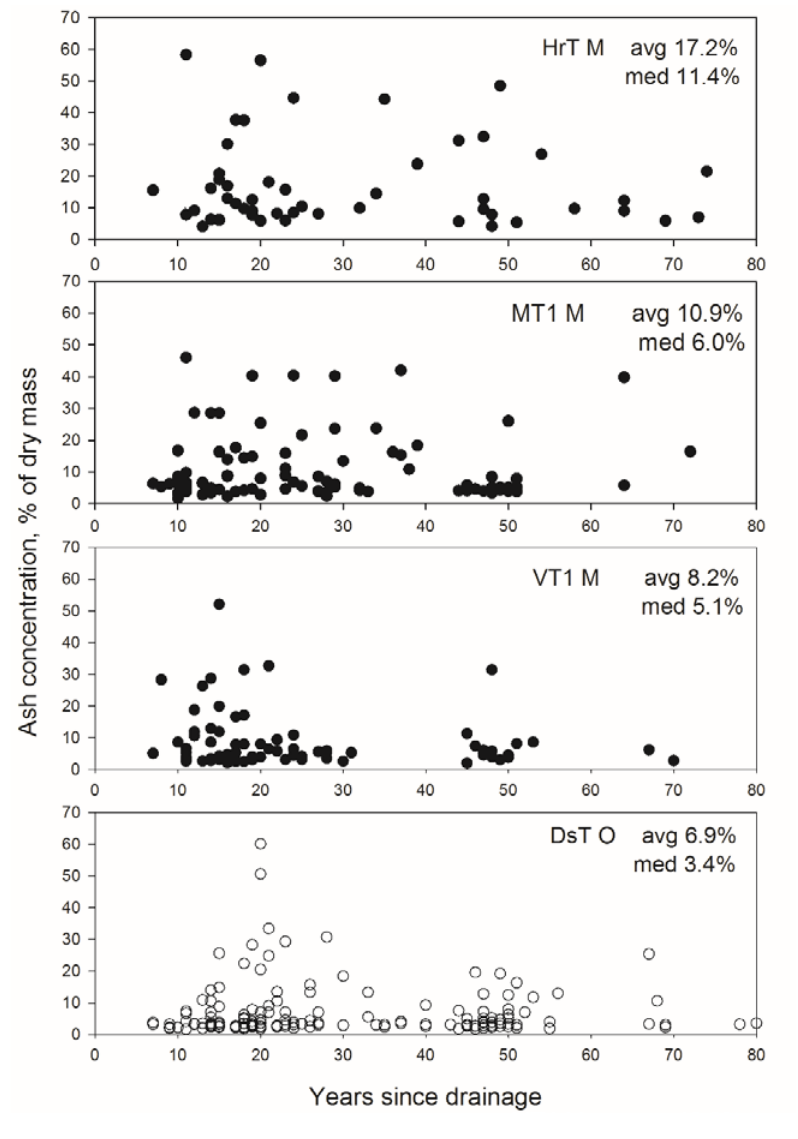
Figure 2. Variation in ash concentration (% of peat dry mass) in a 0–30 cm surface peat layer relative to years passed since drainage within four floristically defined, drained peatland forest site types. Based on the data of Westman & Laiho (2003); ash data previously unpublished. Site types: HrT = herb-rich type (the highest overall nutrient level; see Westman & Laiho 2003) (n = 53), MT = Vaccinium myrtillus type (n = 90), VT = Vaccinium vitis-idaea type (n = 83), DsT = dwarf-shrub type (the lowest overall nutrient level) (n = 154); M = minerotrophic, O = ombrotrophic. Average (avg) and median (med) concentrations shown. The results shown here for the MT and VT sites concern the originally drier group (1) representing forested sites, which were not covered in the material of Laiho & Laine (1994, 1995); those publications targeted the